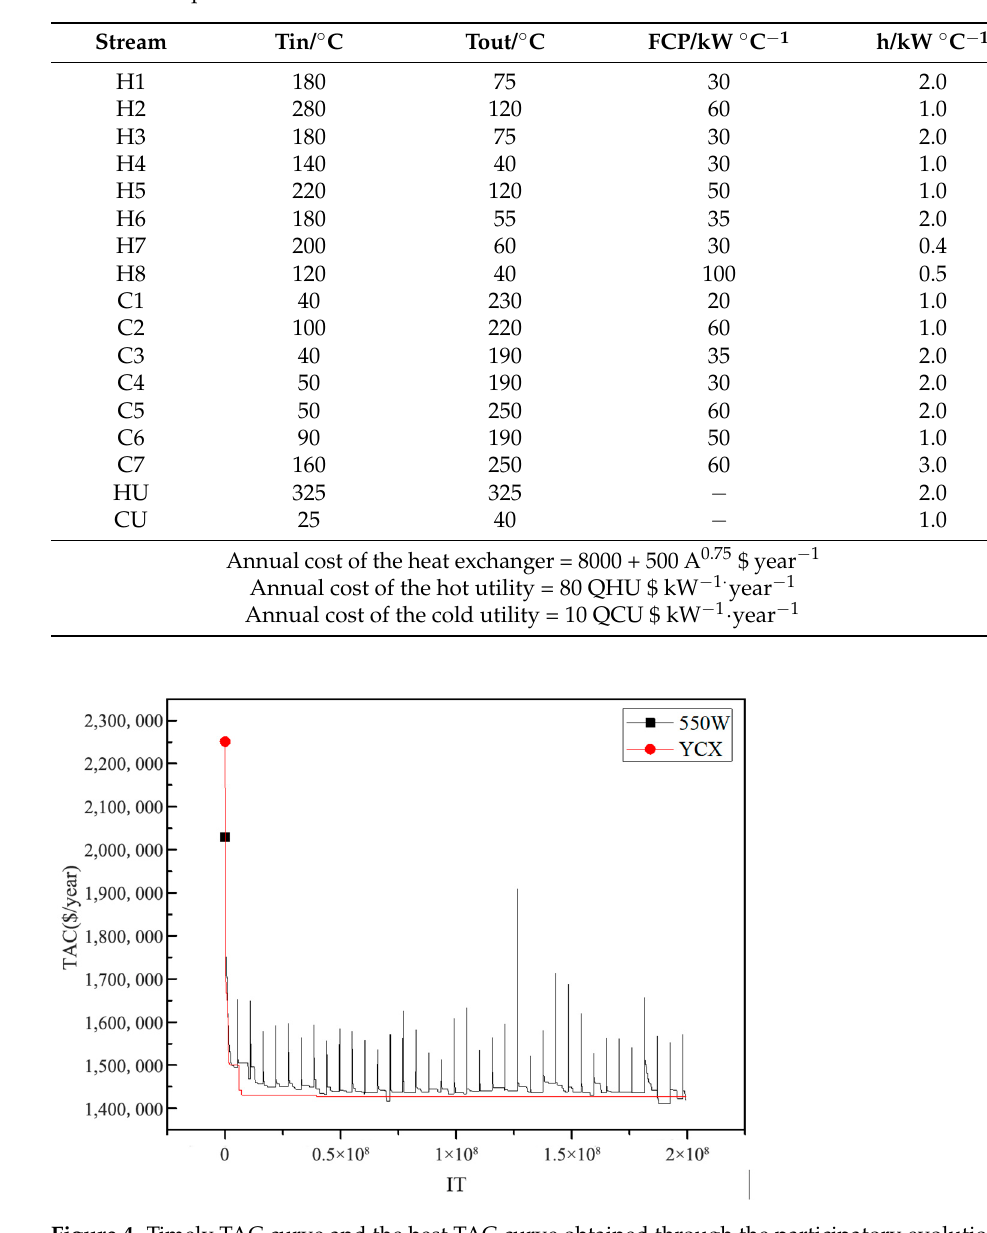
Figure 5. TAC curve of each stream evolution strategy and TAC curve of the original algorithm for Case 1.